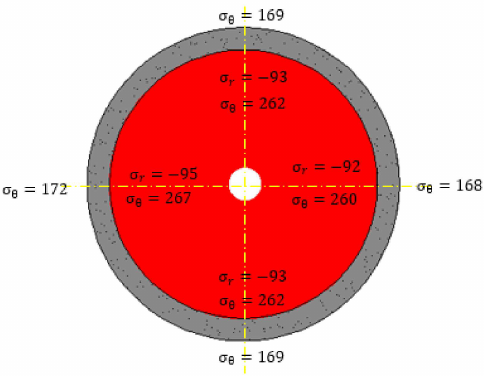
Figure 7. Distribution of hoop and radial stress for lubricated completely cut